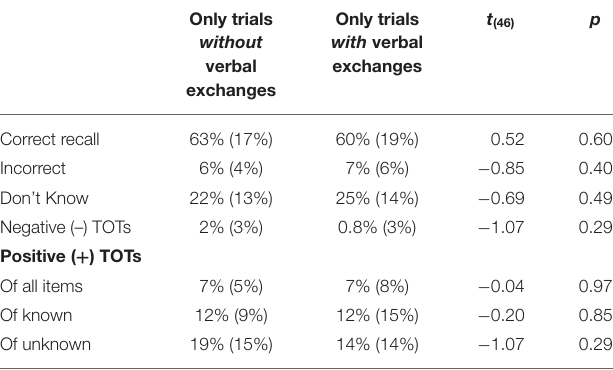
TABLE 4 | Mean (standard deviation) percentages of correctly recalled items, incorrect and “Don’t Know” responses, negative and positive TOT indexes, for trials with and without verbal